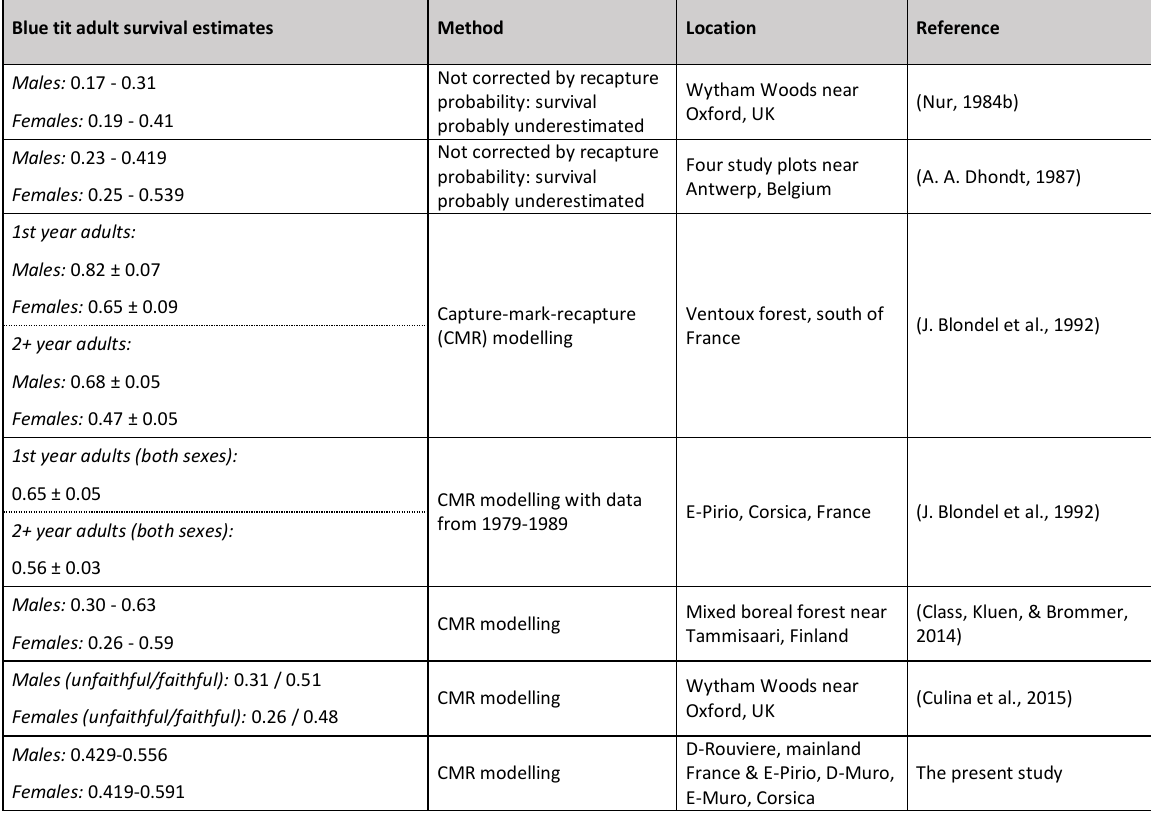
Table 5 : A non-exhaustive list of estimates of blue tit annual adult survival previously published Population density and